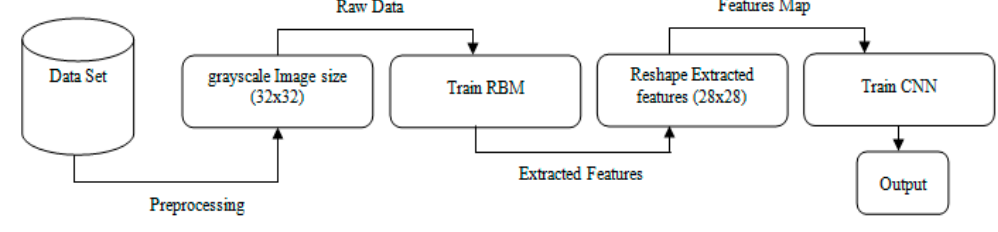
Figure 1. Data flow of the proposed method.